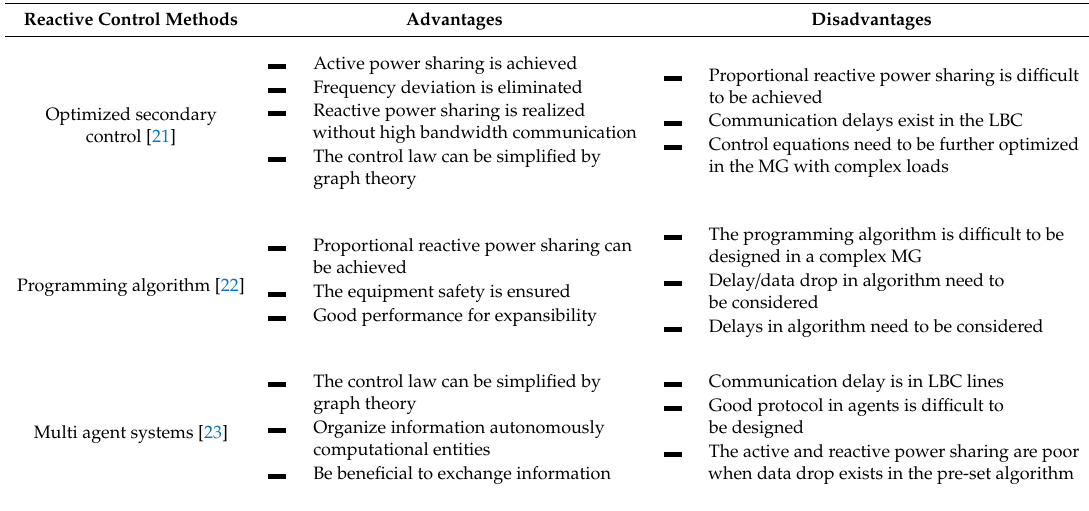
Table 2. Reactive power sharing techniques and